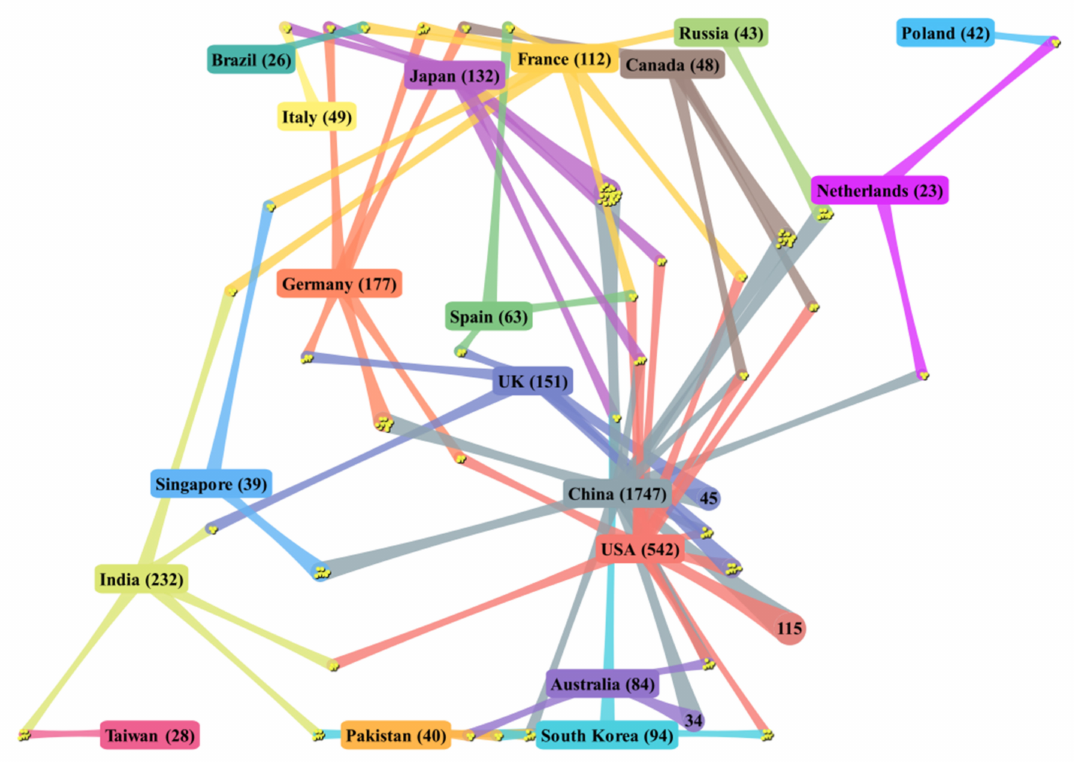
Figure 2. DDA cluster map on collaboration of the top 20 most productive